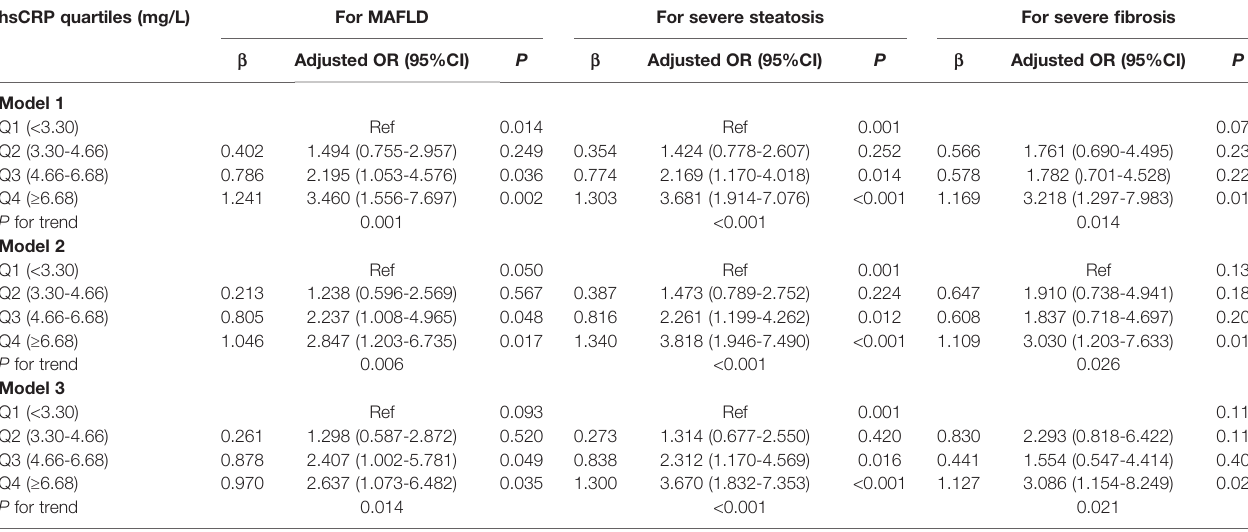
TABLE 3 | Adjusted ORs and 95%CI for MAFLD, severe steatosis, and severe fi brosis based on hsCRP quartiles: results of binary logistic regression